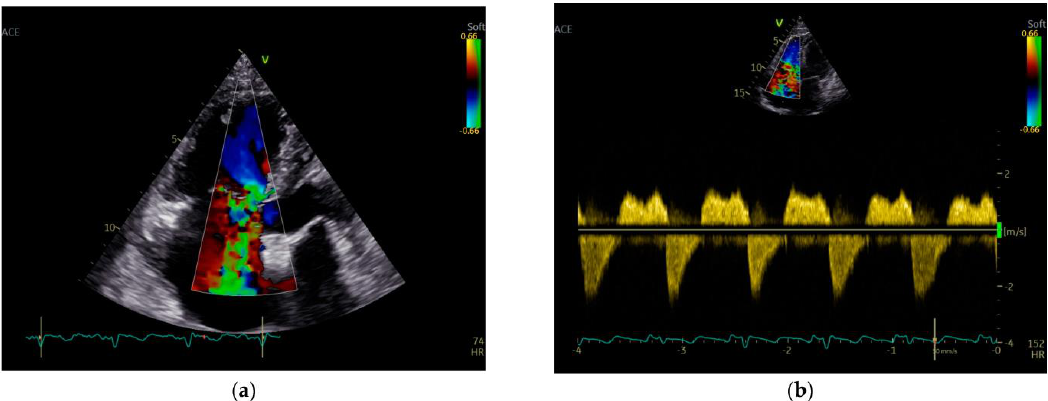
Figure 2. ( a ) Severe tricuspid regurgitation; ( b ) Severe tricuspid regurgitation and moderate tricus- pid stenosis.